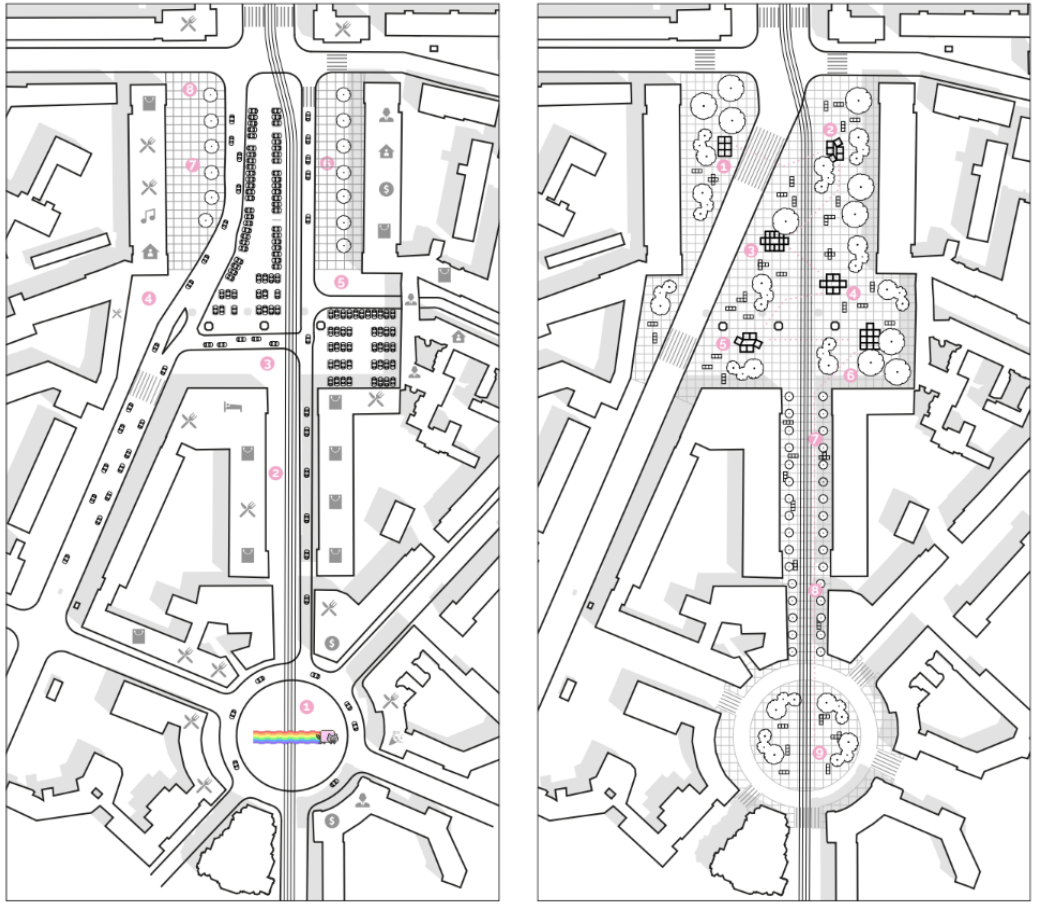
Figure 11. A proposal for the future development of Constitution Square. ( Left ): the existing state. ( Right) : planned, taking into account the location of kinetic spatial forms enabling the organization of public space.